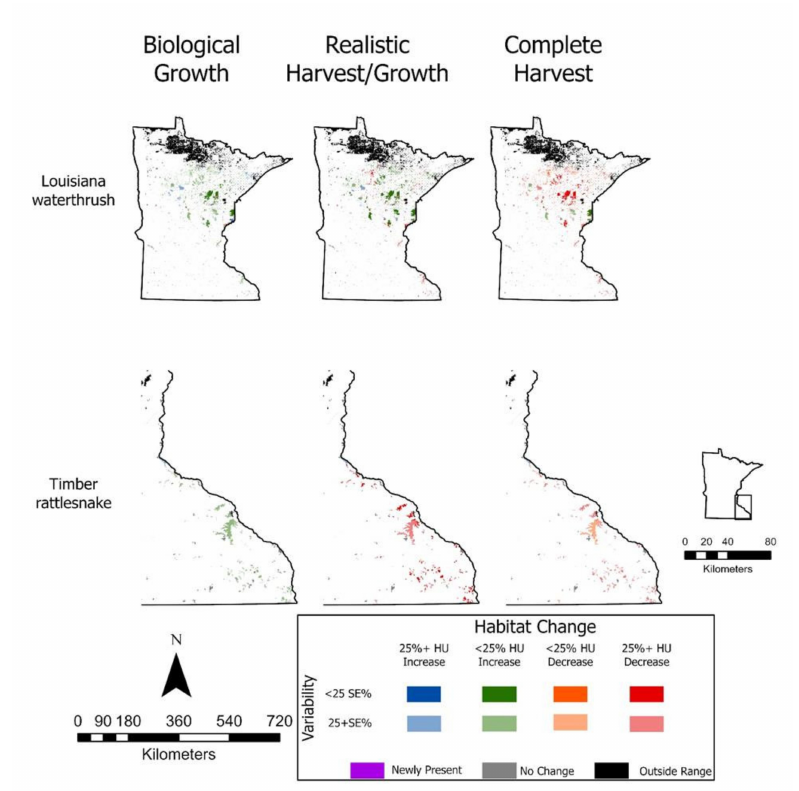
Figure 4. Habitat Unit (HU) percent change of two Minnesota threatened, endangered, and special concerns species under three simulated harvest/growth scenarios on Minnesota Department of Natural Resources lands. SE% refers to the standard error relative to the 2020 HU